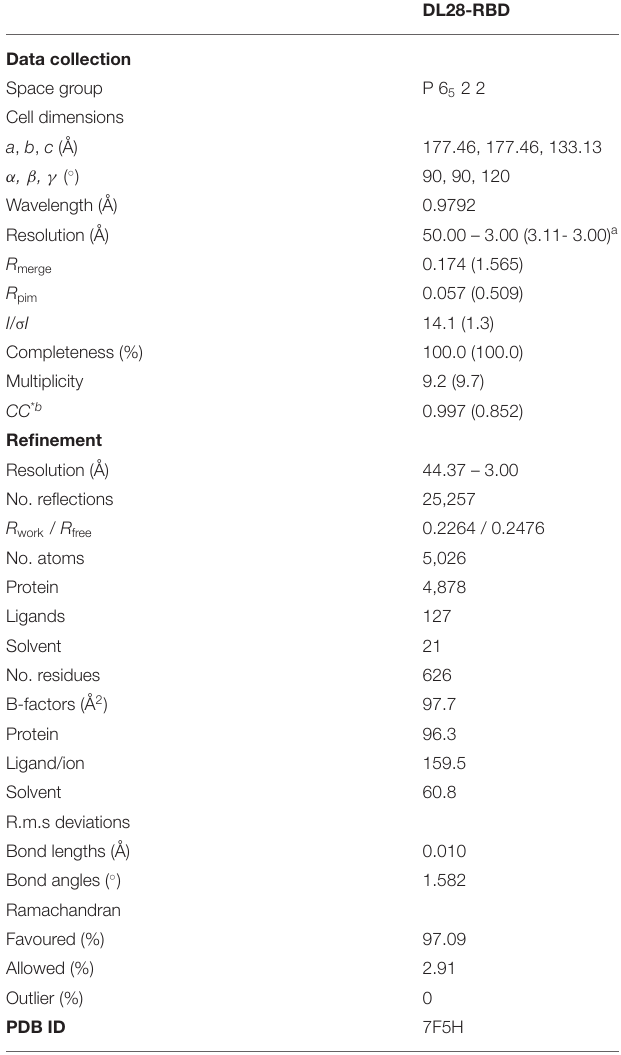
TABLE 1 | Data collection and refinement